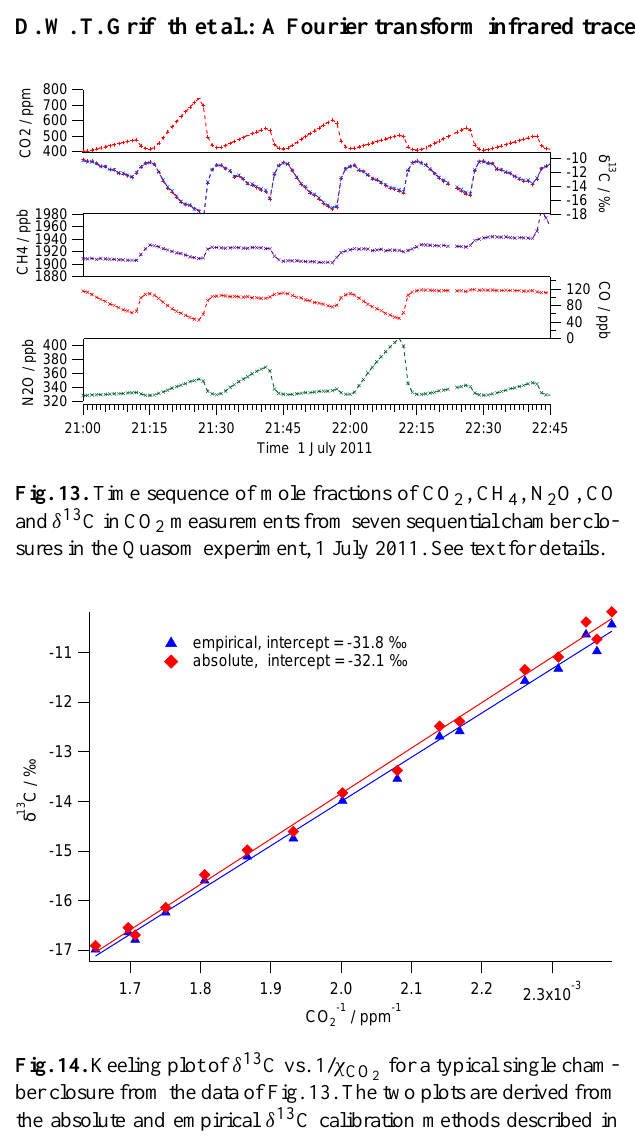
for a typical single cham- 2